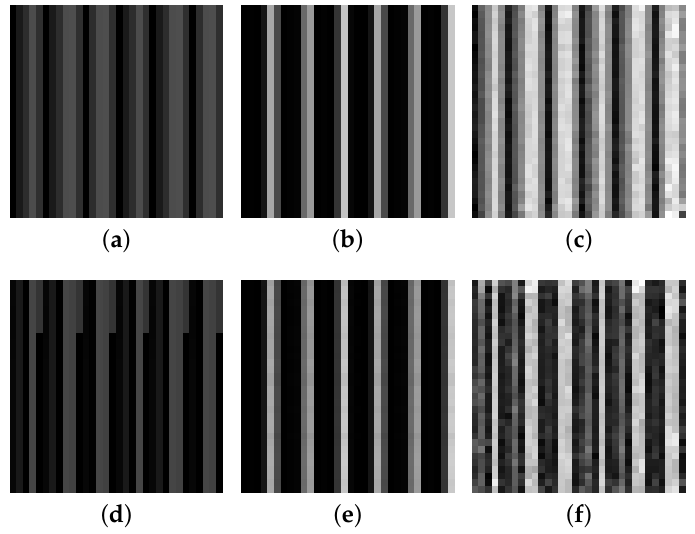
Figure 11. Results of data generation. The first row of data is the normal data, whereas the second row is the fault data: ( a ) real normal data; ( b ) rough normal data; ( c ) refined normal data; ( d ) real fault data; ( e ) rough fault data; ( f ) refined fault